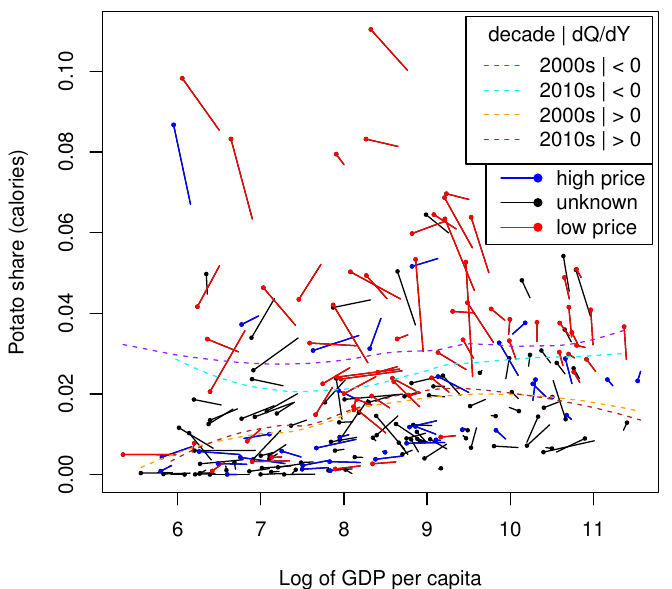
Figure 3. Potato share against GDP per capita. Half of the FAO-areas with unknown producer price data. The limit of 350 USD/1000 kg, using inflation adjusted 2010 dollars, classified known potato prices into high or low for this representation. Developing countries are consistent to their individual country condition dQ/dY in cross-sectional local regression slopes, whereas rich countries cross-sectionally behaved contrarily to their individual country conditions with loess curve rising for descending decade-mean move endpoint data, and vice